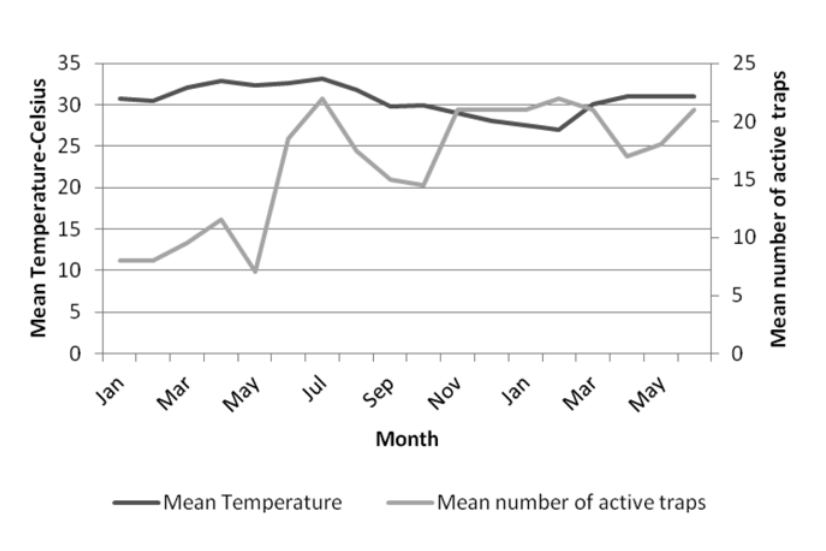
Fig. 3. Mean number of active collection traps (out of 22 total) at the C. gestroi field site in comparison to mean temperature from January 2010 –June